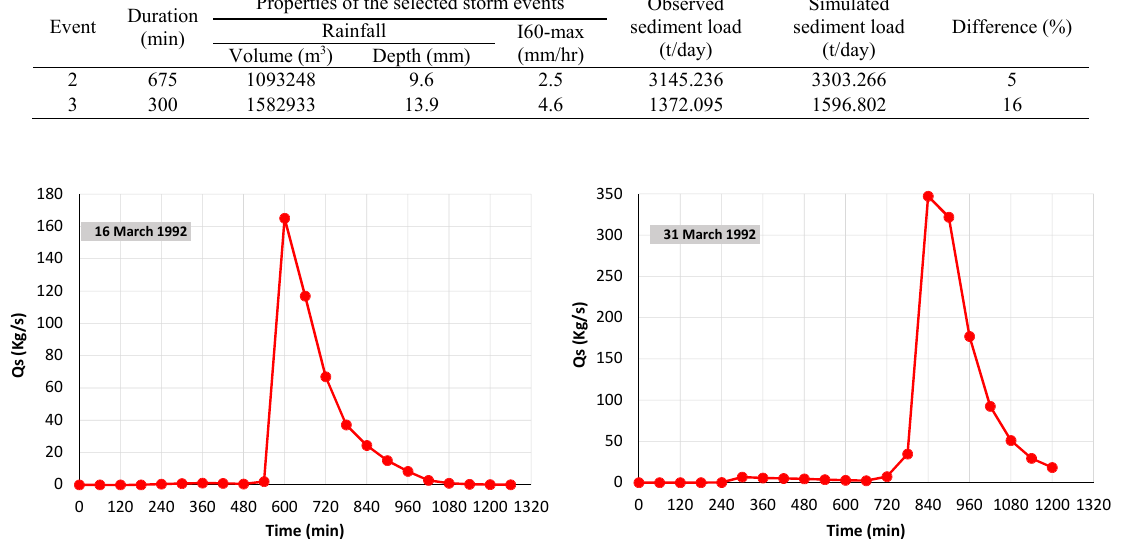
Table 7: The K2 simulation for sediment load according to the selected storm events Event